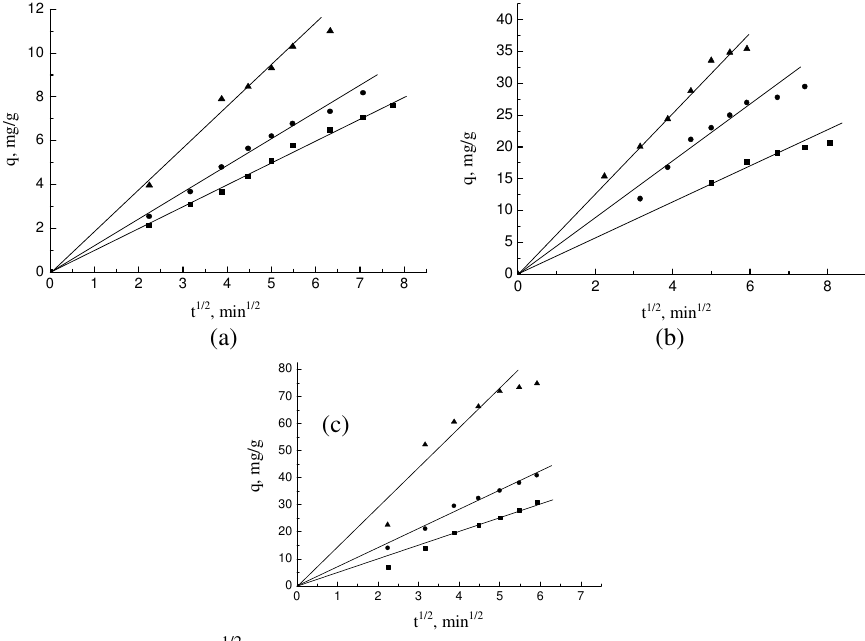
Figure 7 . Plot of q vs . t 1/2 in internal diffusion model of PEG (4000), (a) 50 mg/L, (b) 200 mg/L, (C) 500 mg/L; ( ■ ) 5 °C, ( ● ) 25 °C,( ▲ ) 45 °C